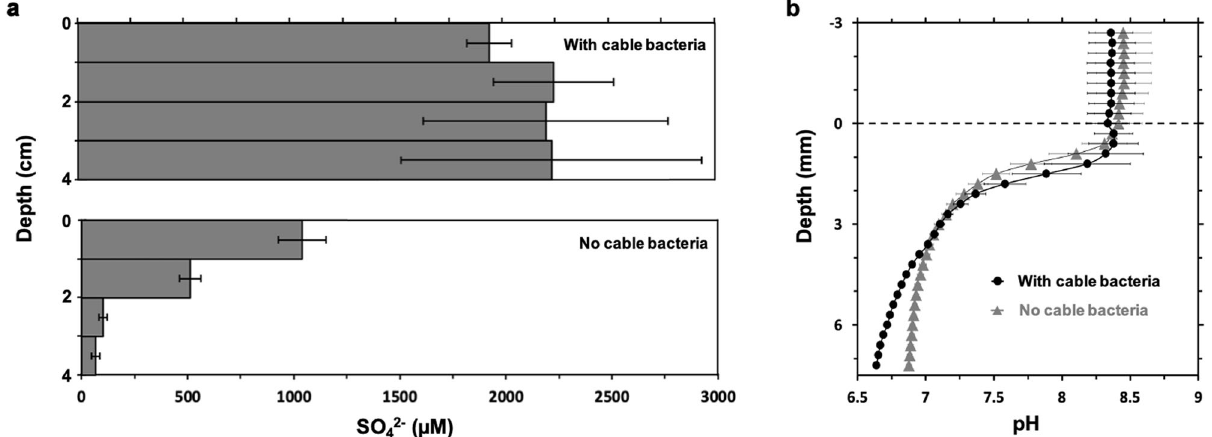
Fig. 2 Sulfate concentrations and pH in the rice-vegetated pots. a Sulfate concentrations in the porewater of pots with cable bacteria (top) and in pots without cable bacteria (bottom). b Depth pro fi les of pH measured with microelectrodes in pots with cable bacteria (circles) and without cable bacteria (triangles). Data are presented as mean ± standard error of the mean ( n = 4).